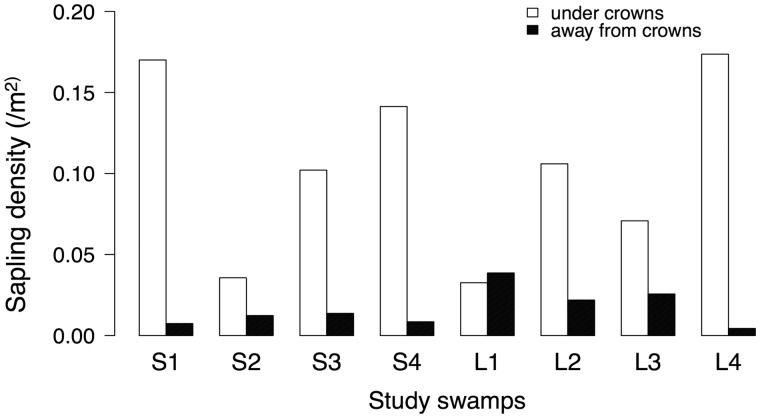
Bar chart shows a comparison of M. fatua sapling densities (/m2) under the crowns versus away from crowns in eight Myristica swamp patches. Swamp sites, L1, L2, L3, L4 are large swamps while S1–S4 are small swamps.